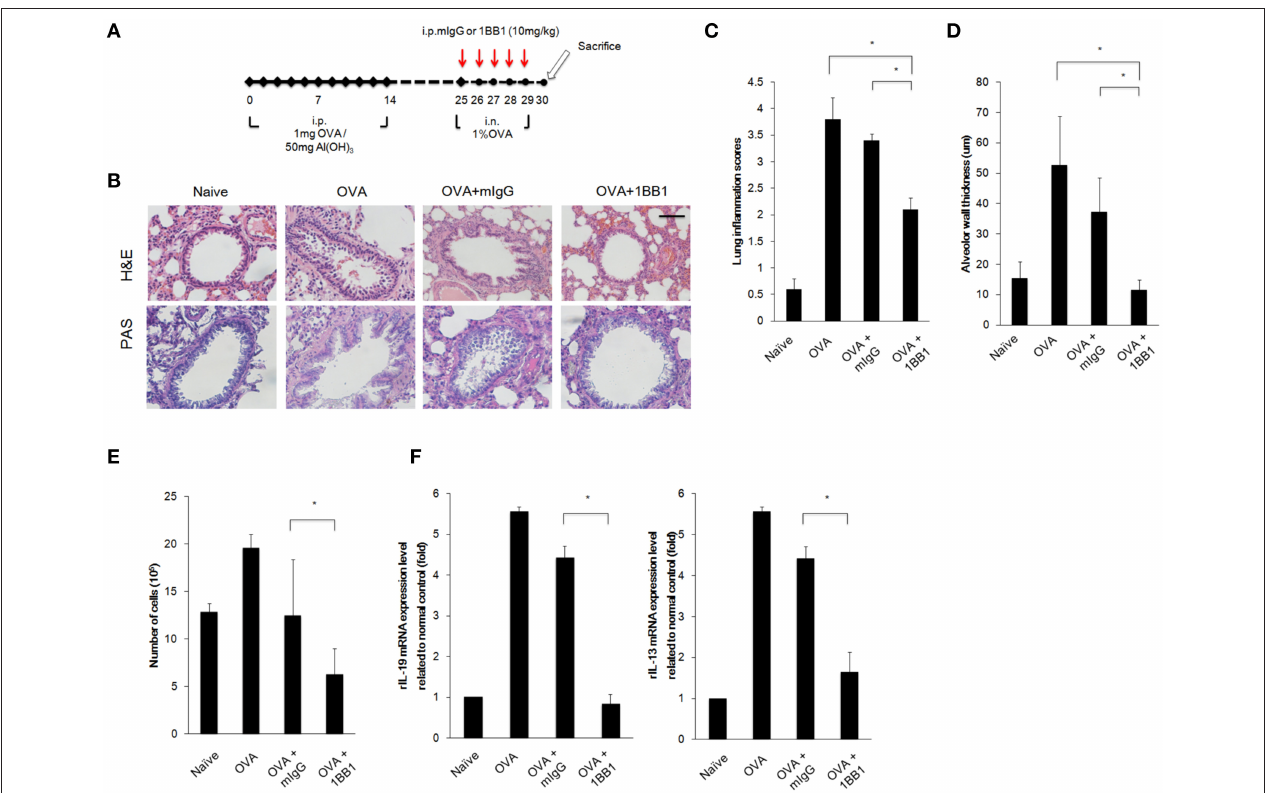
FIGURE 7 | OVA-induced asthma was ameliorated in 1BB1-treated rats. (A) Protocol of ovalbumin (OVA)-induced asthmatic mouse model with anti-IL-19 mAb (1BB1) treatment. Wild-type Sprague-Dawley rats ( n = 6 per group) were intraperitoneally (i.p.) injected with 1mg of OVA adsorbed on 50mg of gelatinous Al(OH) 3 on days 0, 7, and 14. The rats were treated intranasally (i.n.) daily with 1% OVA in 100 µ L of PBS from day 25 for 5 days. They were then dosed via i.p. injection with 1BB1 (10 mg/kg) or immunogammaglobulin (mIgG) (10 mg/kg) (control) 1h before OVA treatment. (B) H&E and PAS staining showed less airway thickening in 1BB1-treated1 asthmatic rats. (C) Lung inflammation scores of the mice. (D) Airway wall thickness. (E) Number of infiltrated immune cells in rat BALF. (F) qRT-PCR analysis for the mRNA levels of IL-13 and IL-19 in rat lung tissue. * P < 0.05 by one-way non-parametric